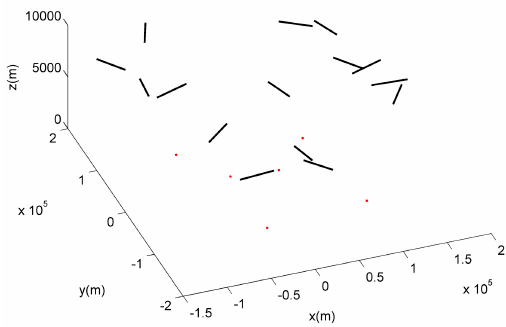
Figure 6. Actual tracks of target and allocation of radars.